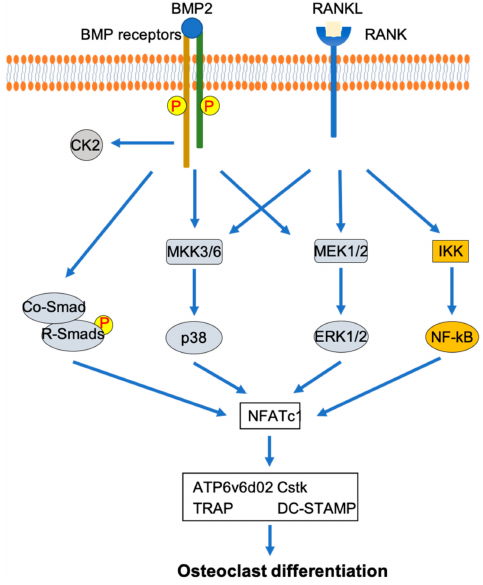
Figure 1. Involvement of p38 MAPK, ERK MAPK, and NF- κ B signaling pathways in osteoclast di ff erentiation mediated by RANKL and